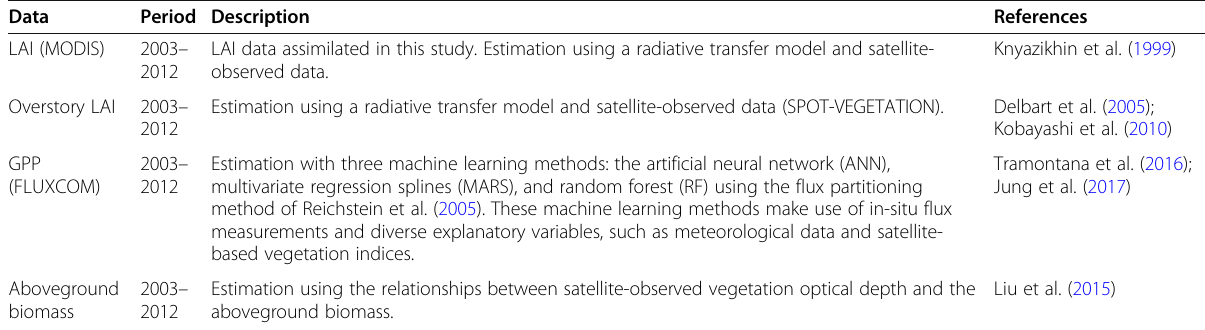
Table 2 Data used for cross-comparisons Data Period